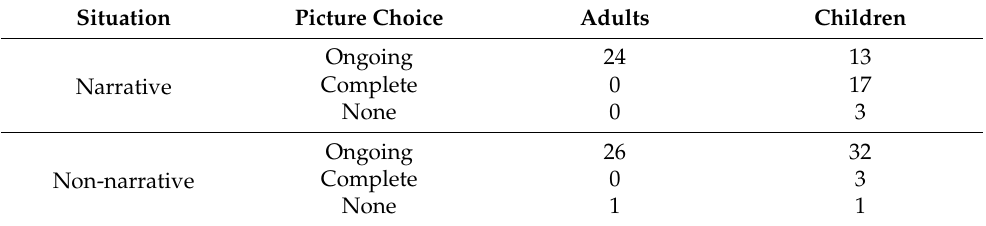
Table 5. Number of times each of the two pictures was chosen for IMP by adults and children in the C–O picture pair condition in the narrative setting (adults n = 8, children n = 11) and the non-narrative setting (adults n = 8, children n = 12) (with three data points per